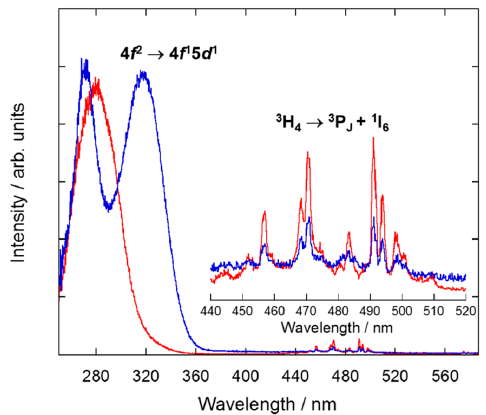
Figure 11. Excitation spectra at C 2 and S 6 (red, λ em = 717 nm; blue, λ em = 603 nm, respectively, see Figure 9) sites of Y 2 O 3 : Pr 3+ NCs prepared by solvothermal method at 220 °C followed by calcination at 1000 °C for 4 h. The inset shows a zoom of the intraconfigurational f-f transitions of Pr 3+ ions.